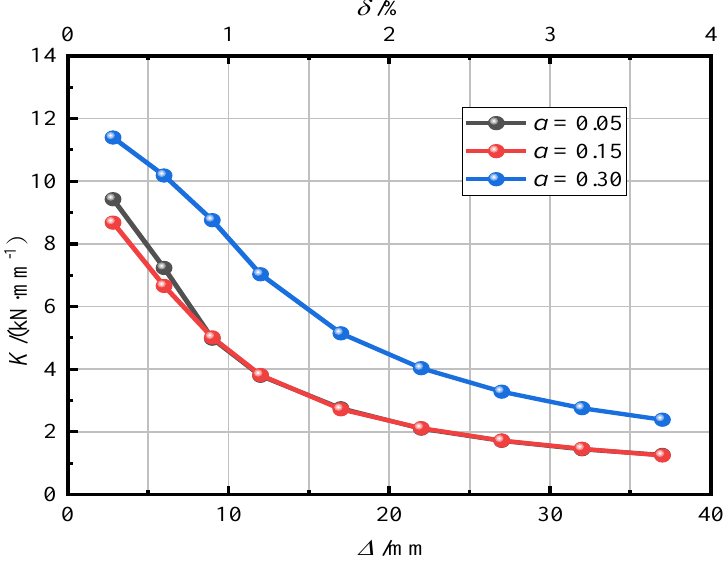
Figure 15. Stiffness degradation law.